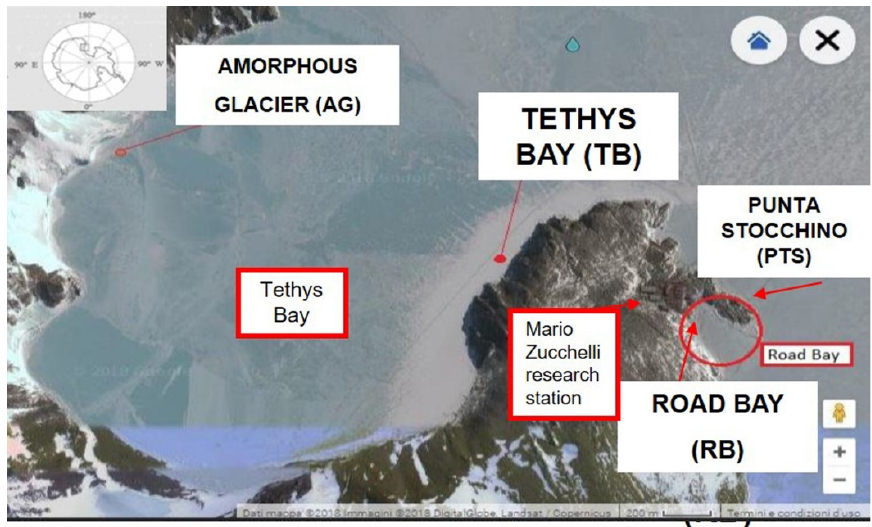
Figure 1. Location of the sampling stations (control and impact) in Tethys Bay and Road Bay (Ross Sea, Antarctica).